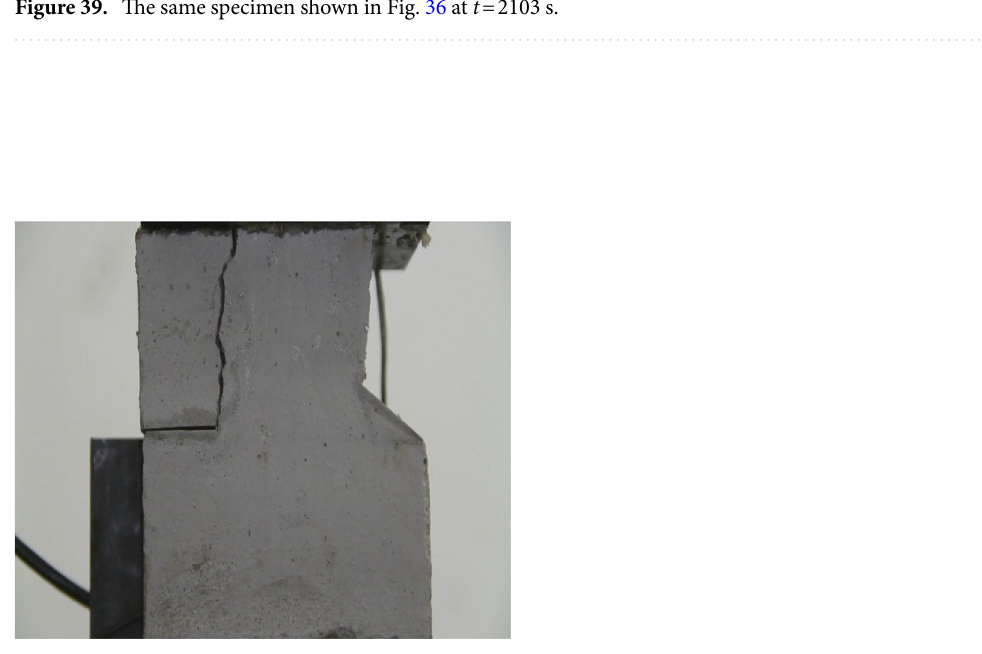
Figure 40. The same specimen shown in Fig. 36 at t = 2561